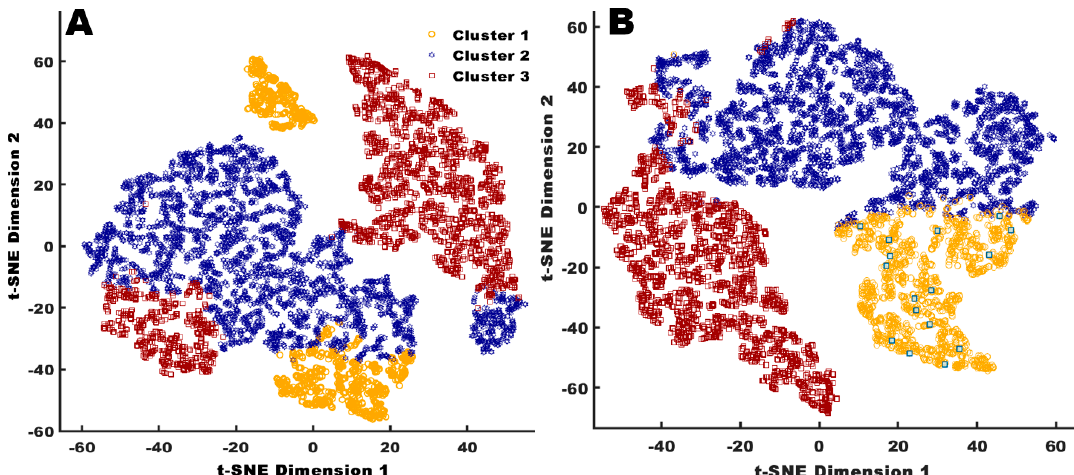
Figure 3. Two-dimensional scatter plot of t -Distributed Stochastic Neighbor Embedding ( t -SNE) visualizing cluster assignments of individual hens by agglomerative ( A ) and K-means algorithm ( B ), where cluster 1 hens (orange circles), cluster 2 hens (dark blue star), and cluster 3 hens (dark red square), grouped according to their similarity of time duration at the feeders, nest boxes, and on the range.